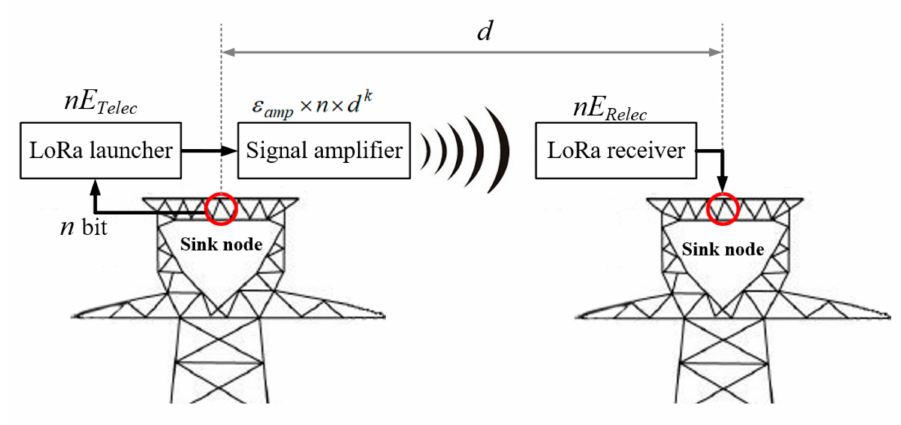
Figure 5. Long range radio (LoRa) communication energy